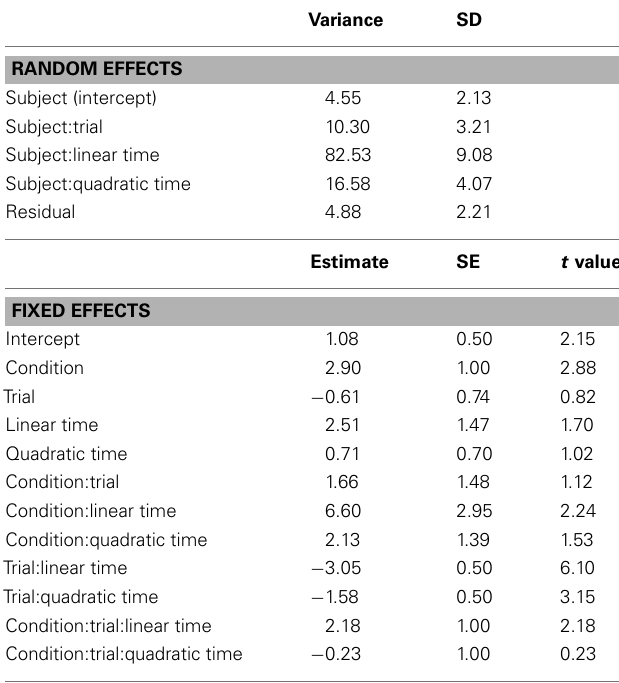
TableA2 | Growth curve model results forTrials 9 and 10 for the sample of infants who were sensitive to the probability structure of the materials.